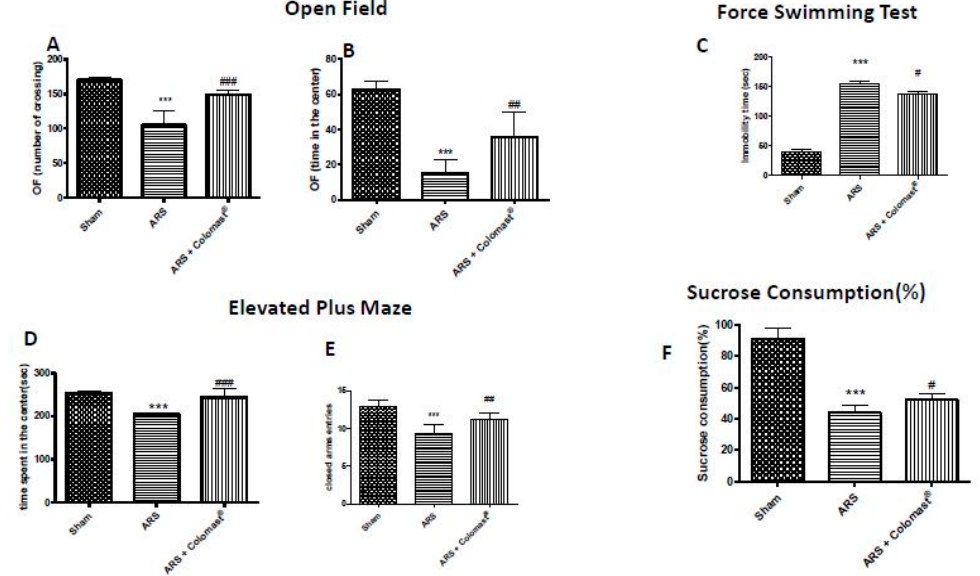
Figure 12. Effect of Colomast ® pre-treatment on behavioral alteration and sucrose consumption (%). Open field test: number of crossing ( A ), time spent in the center ( B ). Force swimming test ( C ). Elevated plus maze test: time spent in the center ( D ), number of entries in the open arms ( E ). Sucrose consumption (%) ( F ). Values shown are means ± SEM of six animals in each group. *** p < 0.001 vs. sham; # p < 0.05 vs. ARS group; ## p < 0.01 vs. ARS group; ### p < 0.001 vs. ARS group.